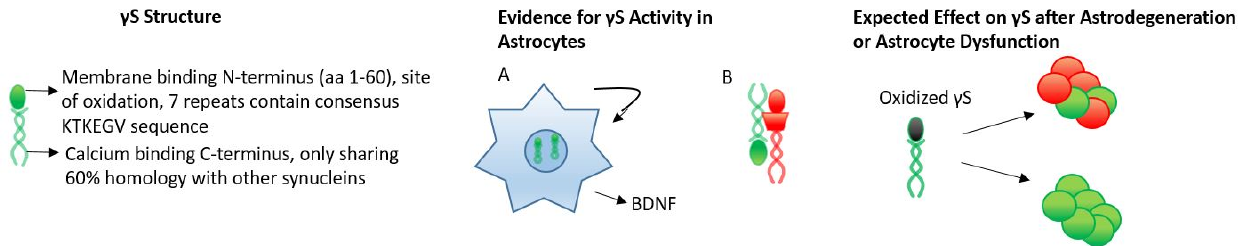
Figure 3. γ S differs the most in sequence to the synucleins, sharing only 60% homology with α S due to its highly variable C-terminal region. Like α S, γ S has 7 repeats with the KTKEGV consensus sequence in the N-terminal region. In A, it has been shown that γ S is capable of inducing astrogenesis and astroprotection through increased expression and release of BDNF. Similarly, knockdown of γ S in astrocytes results in a mitotic catastrophe and apoptosis. In B, it has been shown that γ S can inhibit α S aggregation, which has not been studied in vivo, and could possibly occur in astrocytes, where it is expressed. Oxidation of γ S results in toxic aggregations of γ S itself, influencing the aggregation of α S. As reactive oxygen species’ production is a hallmark of astrocyte dysfunction or astrodegeneration, detrimental oxidized γ S would likely be a byproduct.